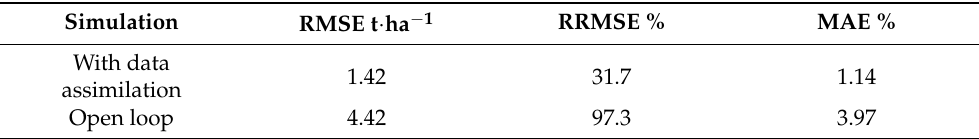
Figure 7. Data assimilation of LAI retrieved from Sentinel 2 into SAFYsw model. For each durum wheat field ( a – g ), the graphs represent the LAI curve fitted on Sentinel-2, the LAI simulated without data assimilation (open loop) and the LAI simulated with data assimilation (see legend in panel h )). EO-derived LAI curves and LAI curves simulated with data assimilation overlaps. Table 2. Performance metrics of yield estimations for 2019 with and without data assimilation. (relative RMSE) is in percentage. Metrics are obtained by comparing predicted and observed yield for each